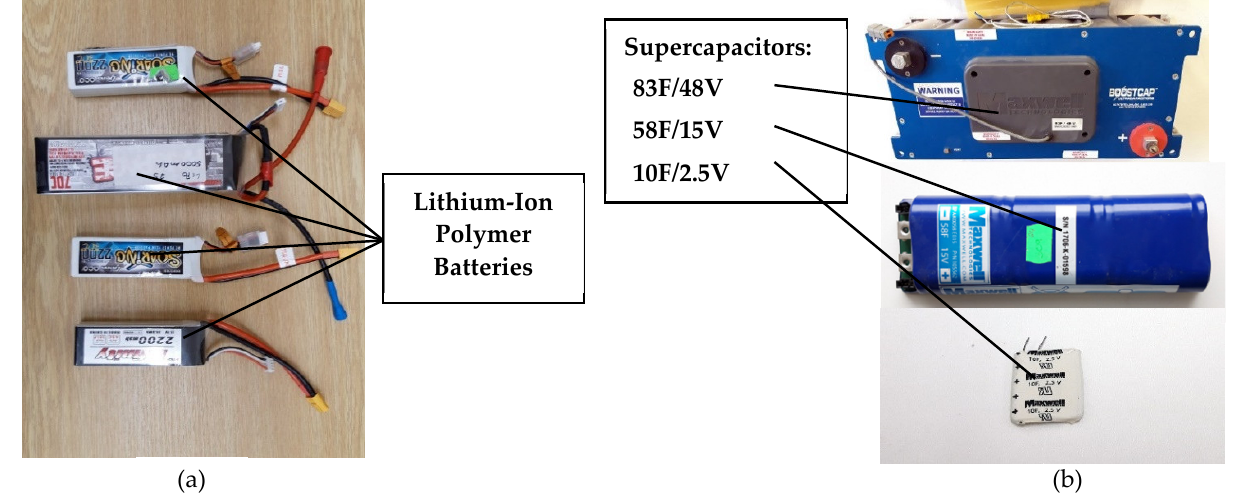
Figure 11. Electrical energy storage systems: ( a ) battery; ( b ) supercapacitors.